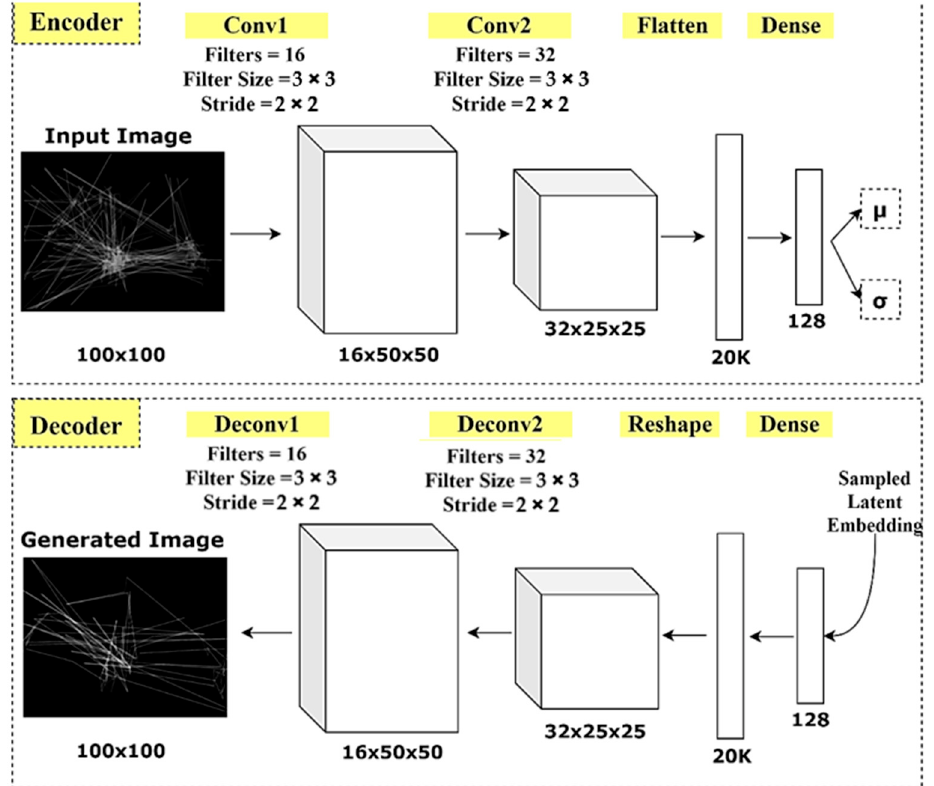
Figure 5. The architecture of the VAE model.